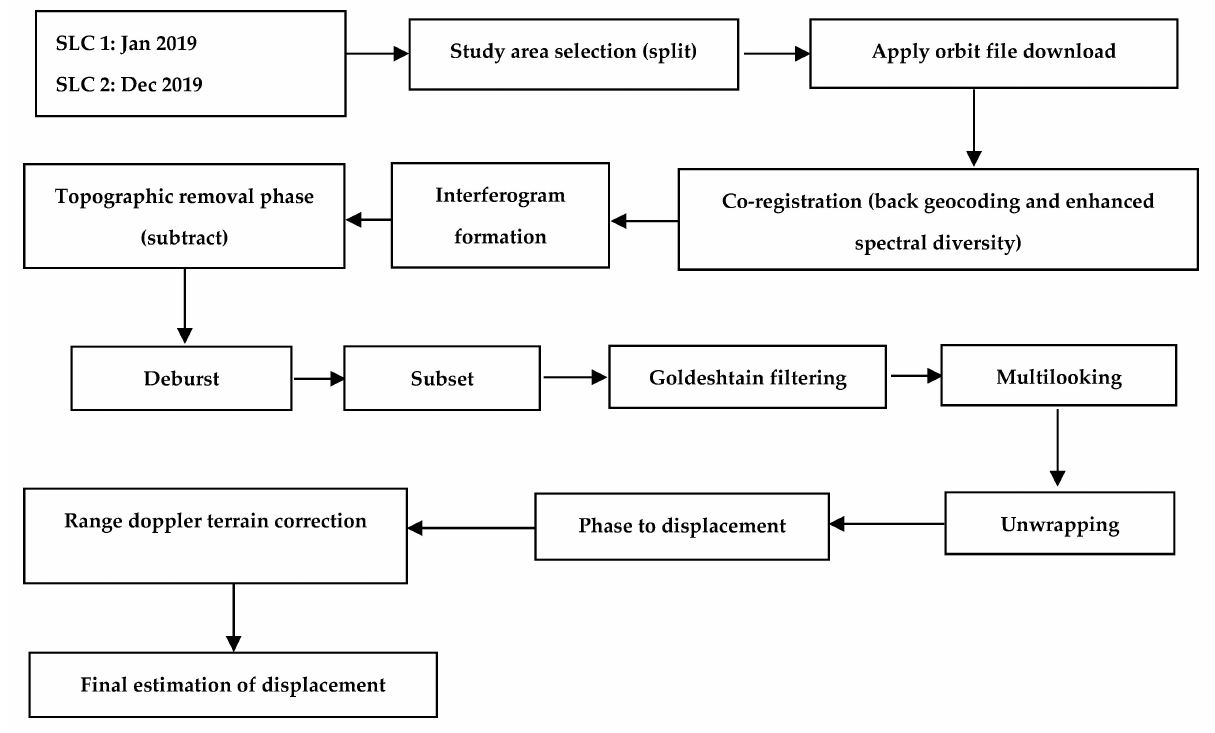
Figure 4. Interferometric synthetic aperture radar (InSAR) processing conceptual flowchart (image developed by the